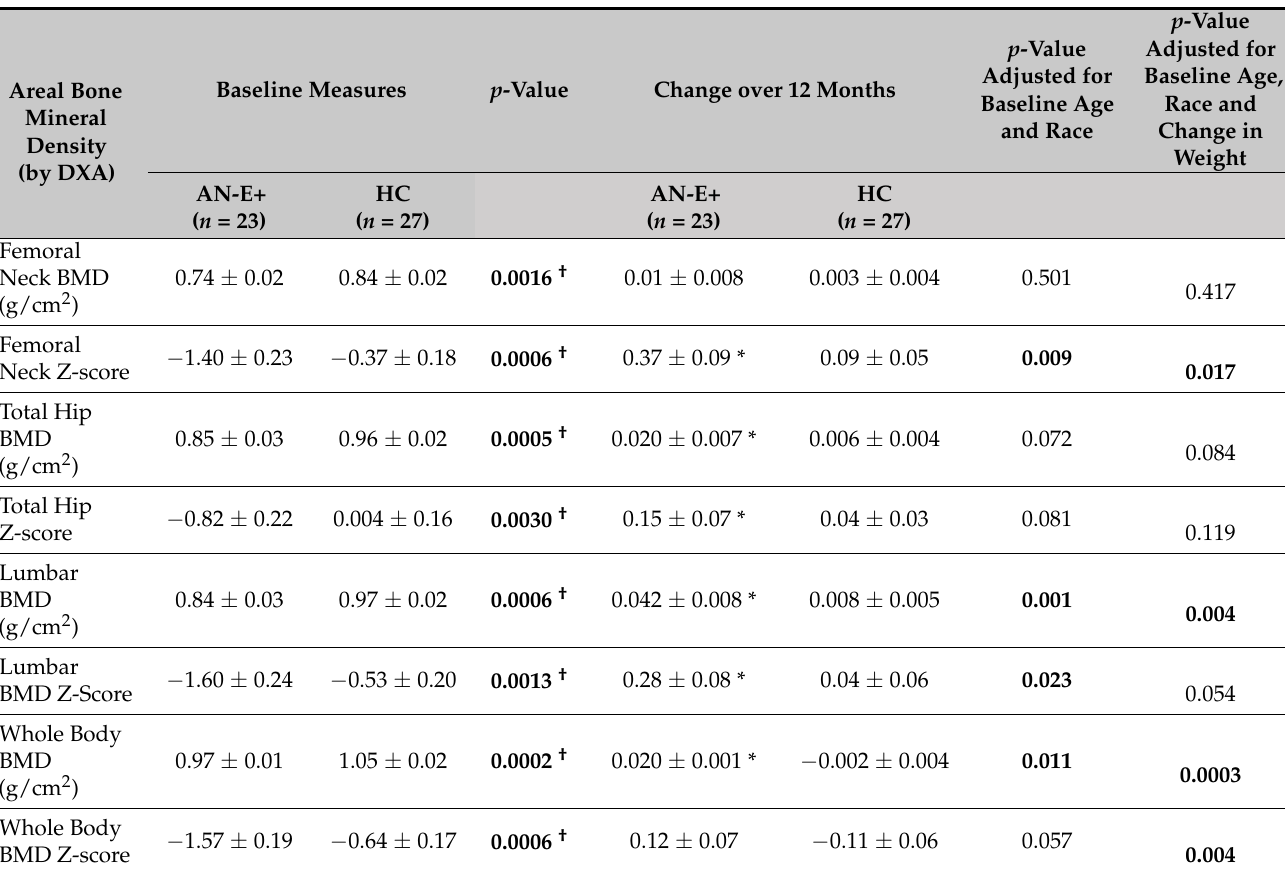
Table 3. Baseline and 12-month change in areal BMD assessed by